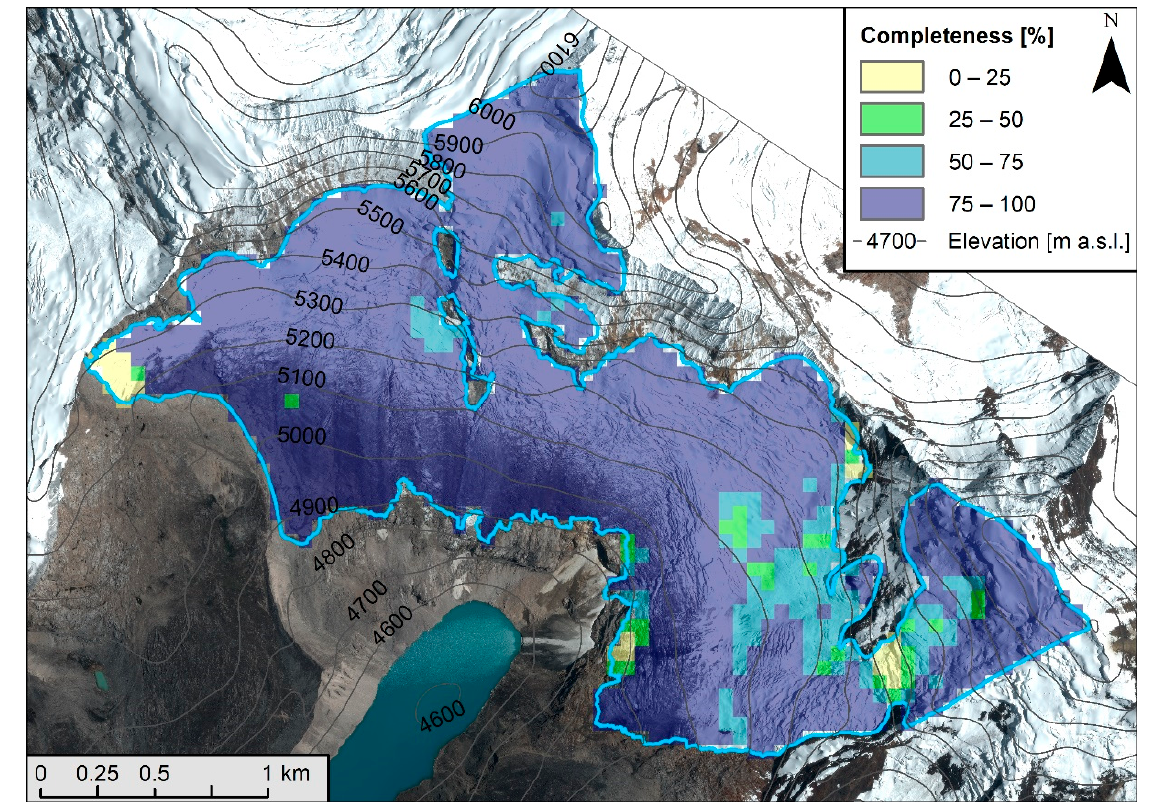
Figure 5. Spatial distribution of sampling completeness.